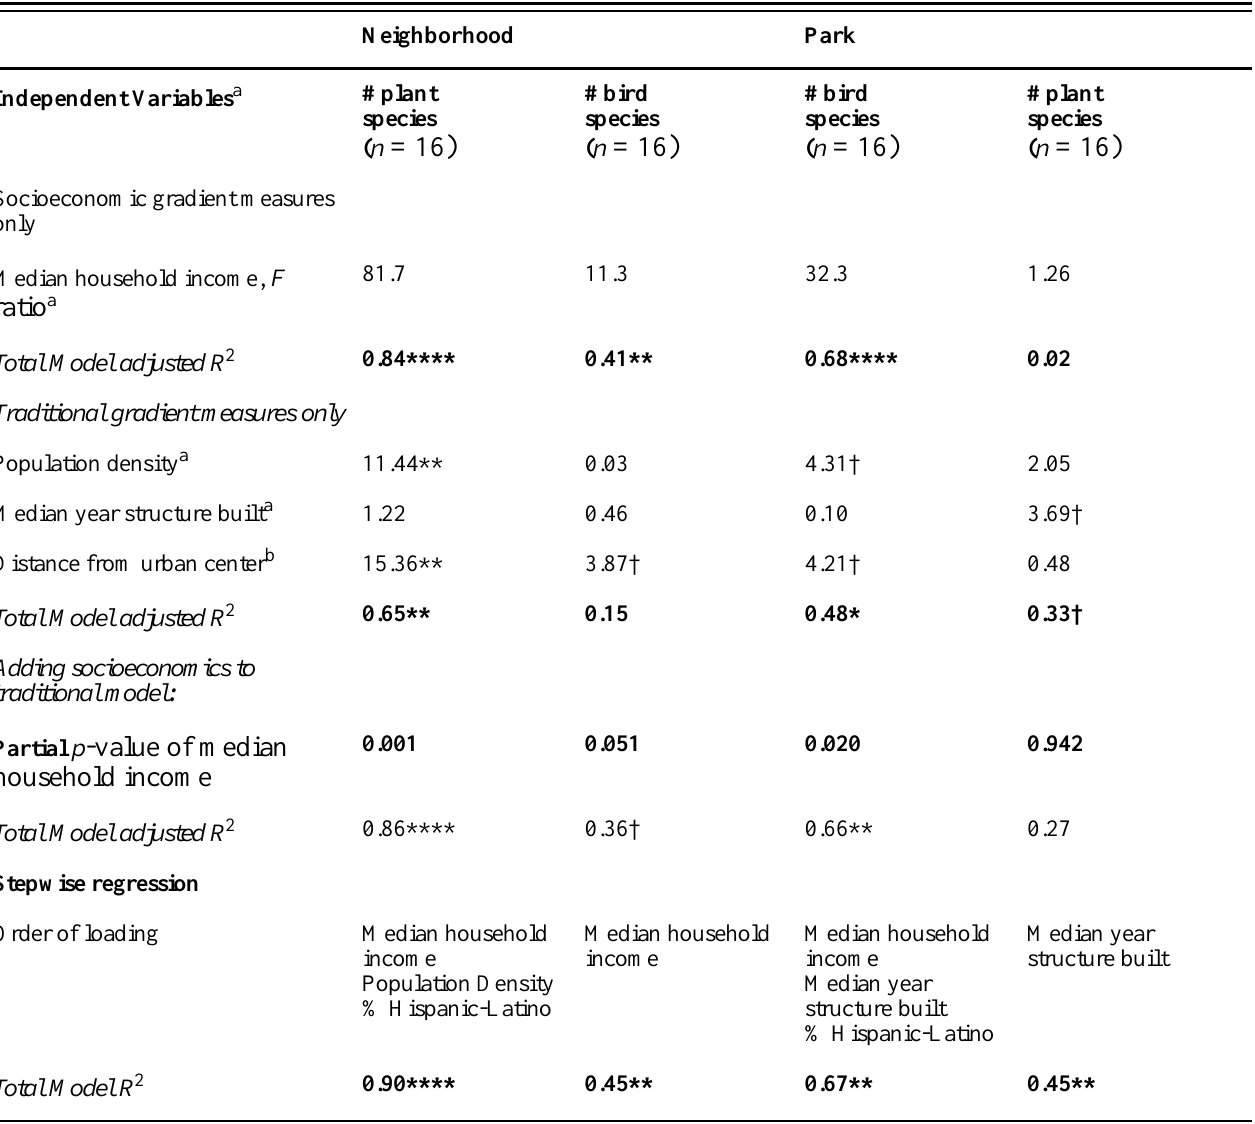
Table 1. Multiple regression analyses for traditional gradient measures and socioeconomic gradient measures. The influence of neighborhood socioeconomic status is expected to decrease from left to right. The effect of adding income (a socioeconomic factor) to a model containing the traditional gradient measures is shown by the partial p -value for income. Partial p -values were predicted to increase from left to right. The remaining cells contain the F -ratios for each independent variable in the model and adjusted R 2 values for total models. Significance is indicated as: † p < 0.1; * p < 0.05; ** p < 0.01; *** p < 0.001; **** p < 0.0001. A greater number of *’s indicates a greater level of statistical significance, making it more likely that bird or plant diversity is influenced by the variable(s) of